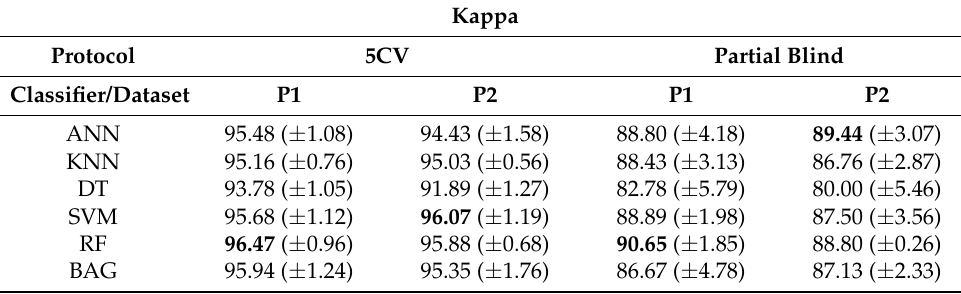
Table 3. Kappa results of different classifiers for arrhythmia classification in the two proposed